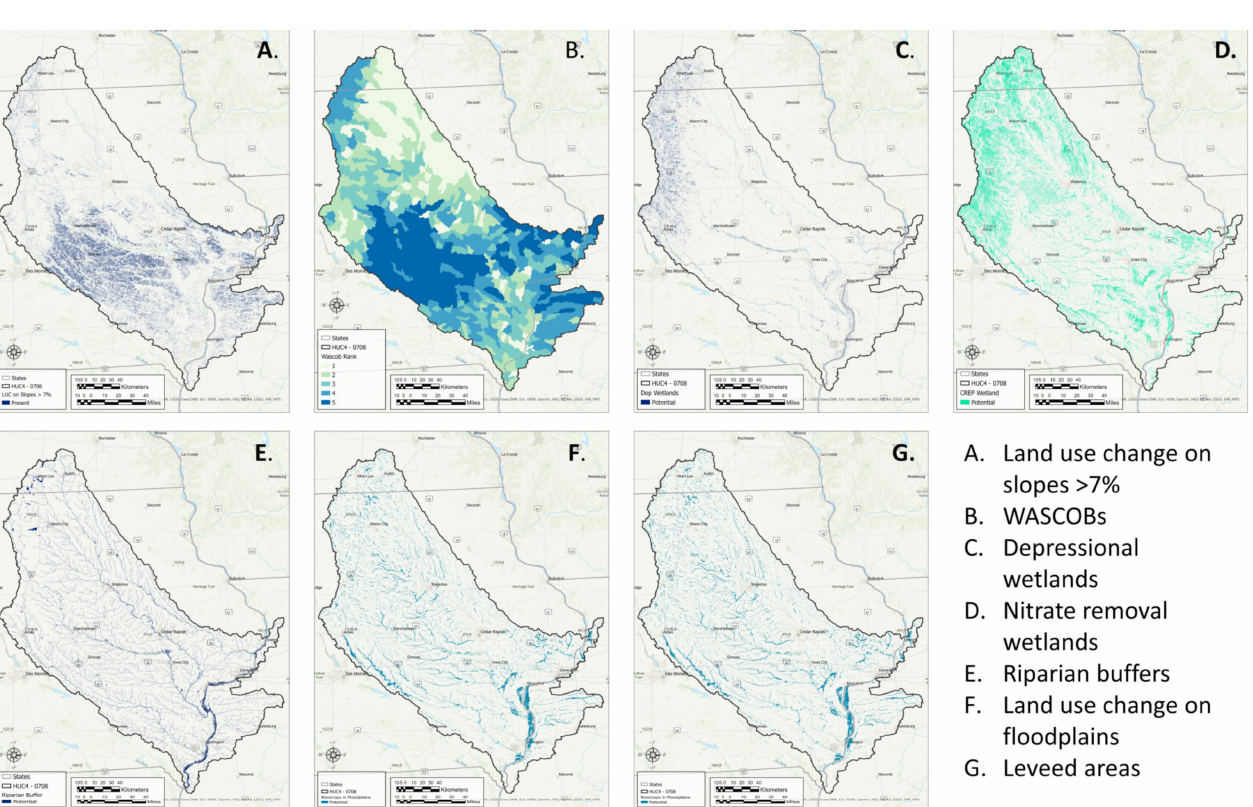
Figure 5. NI practices mapped at the 10 m scale in the Iowa-Cedar basin (see Table 1 for specific details). ( A ) Land use change on slopes >7%, ( B ) WASCOBS, ( C ) Depressional wetlands, ( D )